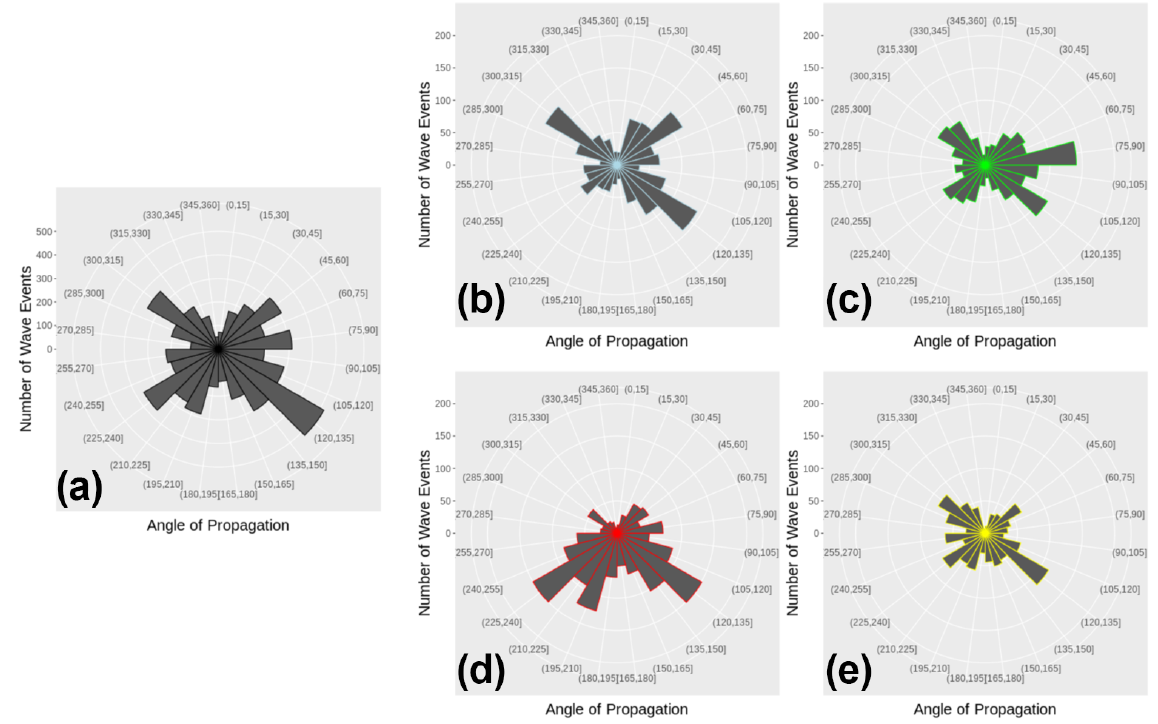
Figure 3. Statistical distribution of observed directions of propagation for wave events with horizontal wavelengths between 48m and 4.5km from 26 October 2017 to 6 June 2019 at Otlica, Slovenia. (a) All; (b) winter (December–January–February); (c) spring (March–April–May); (d) summer (June–July–August). (e) Autumn